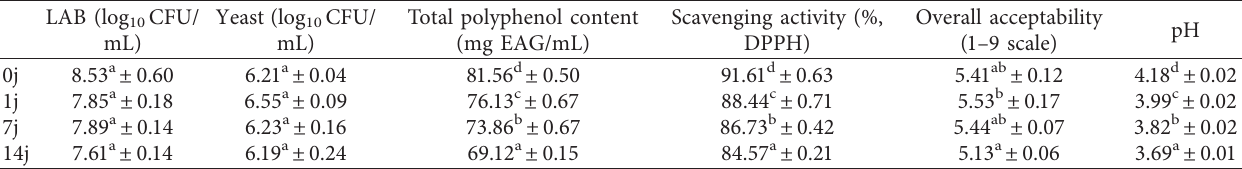
Table 7: Microbial viability and the change in physicochemical parameters during refrigerated